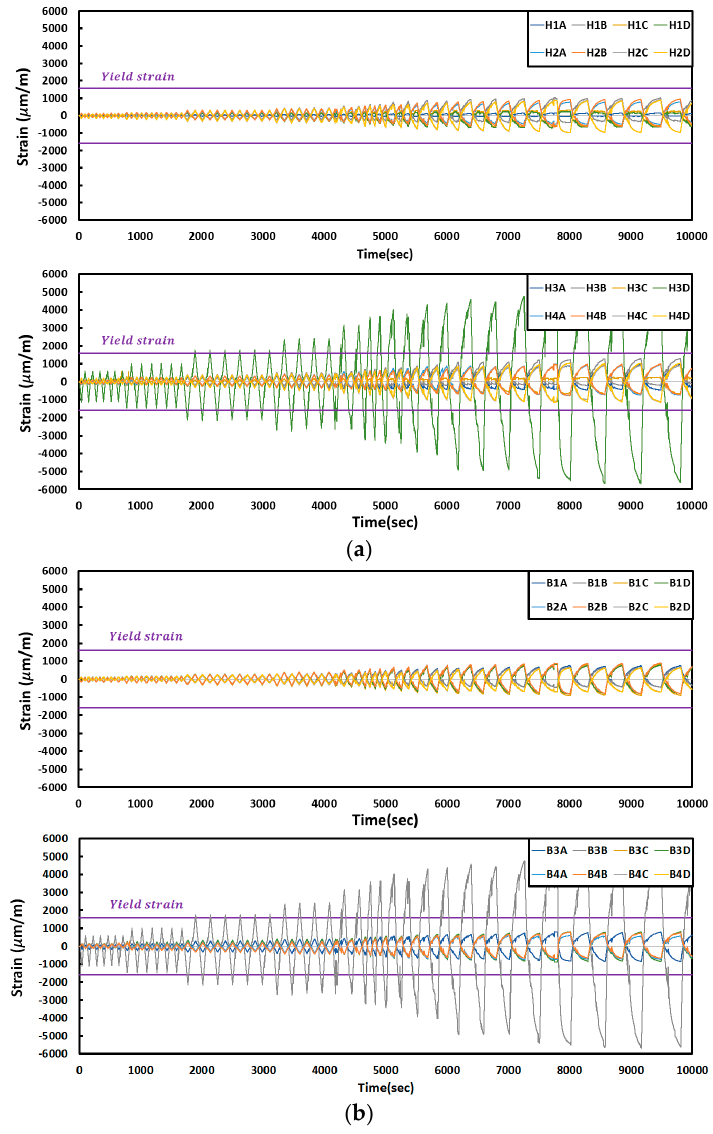
Figure 10. Strain curves of the specimens (FR-00): ( a ) column; ( b ) beam.